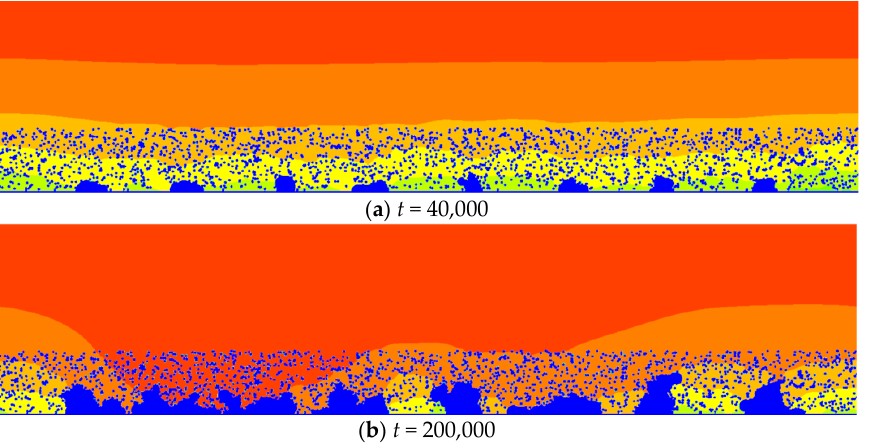
Figure 8. Distributions of oxygen concentration.